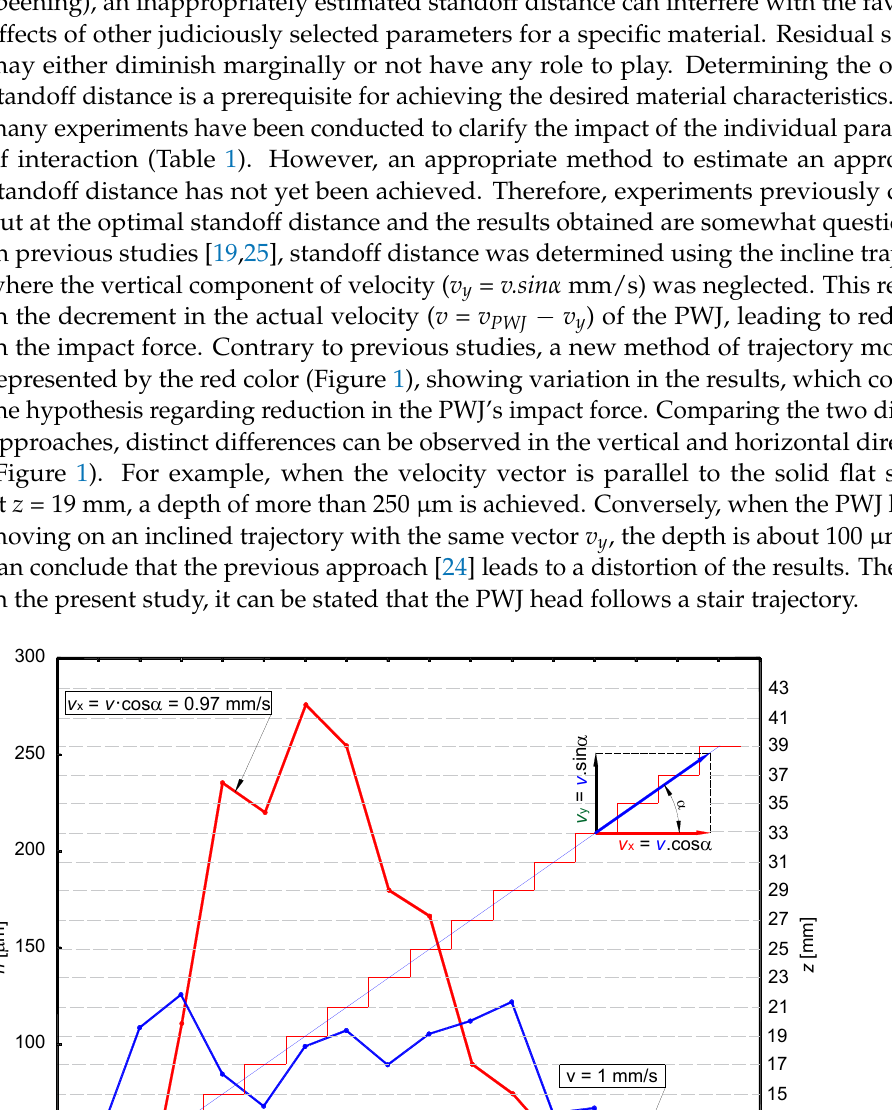
Table 3. Mechanical properties of AISI 304 [24].